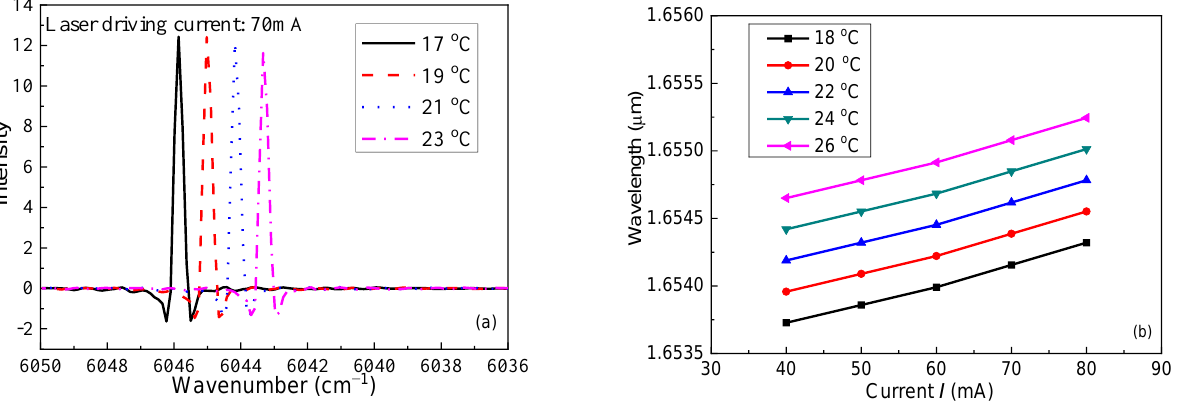
Figure 6. Spectrum tests of temperature shifting while current is stable ( a ) and current changing while temperature is fixed ( b ).